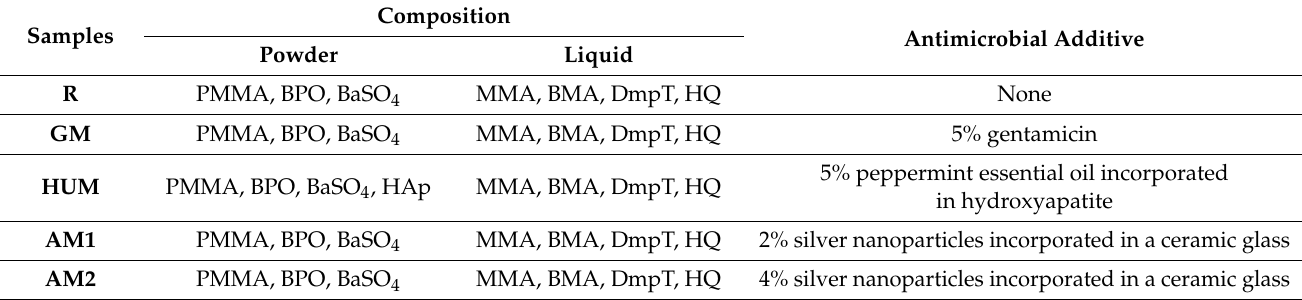
Table 1. Composition of the standard and new antimicrobial bone